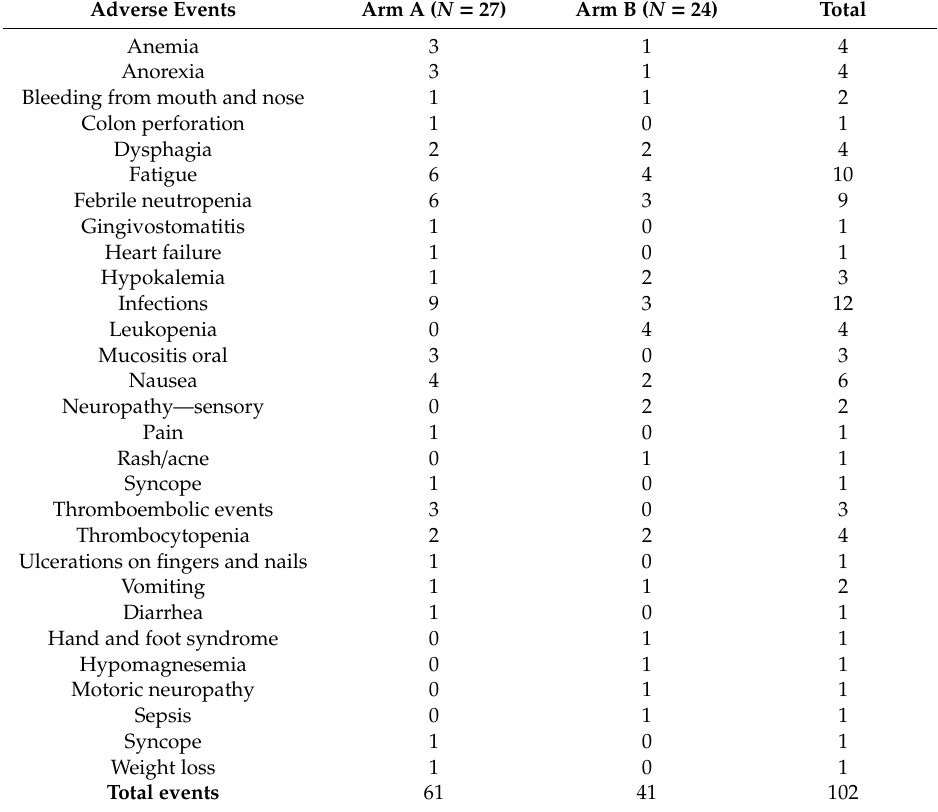
Table 3. Adverse events ≥ grade